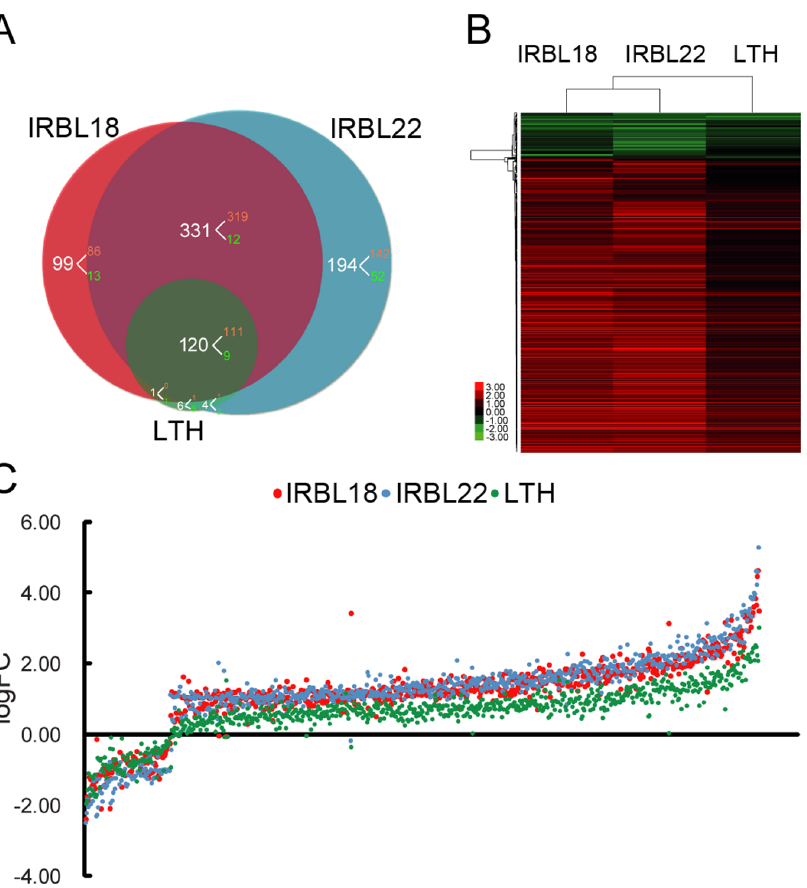
Figure 2. Differentially expressed genes (DEGs) identified from the transcriptome study. A: The venn diagram of DEGs in IRBL18, IRBL22 and LTH. The numbers of up- and down-regulated genes were shown in red and green, respectively. B: Hierarchical clustering of the log2- transformed fold changes. The scale bar displays log2-transformed fold changes. C: Scatter plot of log2-transformed fold changes. doi:10.1371/journal.pone.0059720.g002 assessedwiththe17,752expressedgenesasreference.Intheresistant IRBL18andIRBL22,thegenesinvolvedin‘‘signaling’’,‘‘aminoacid